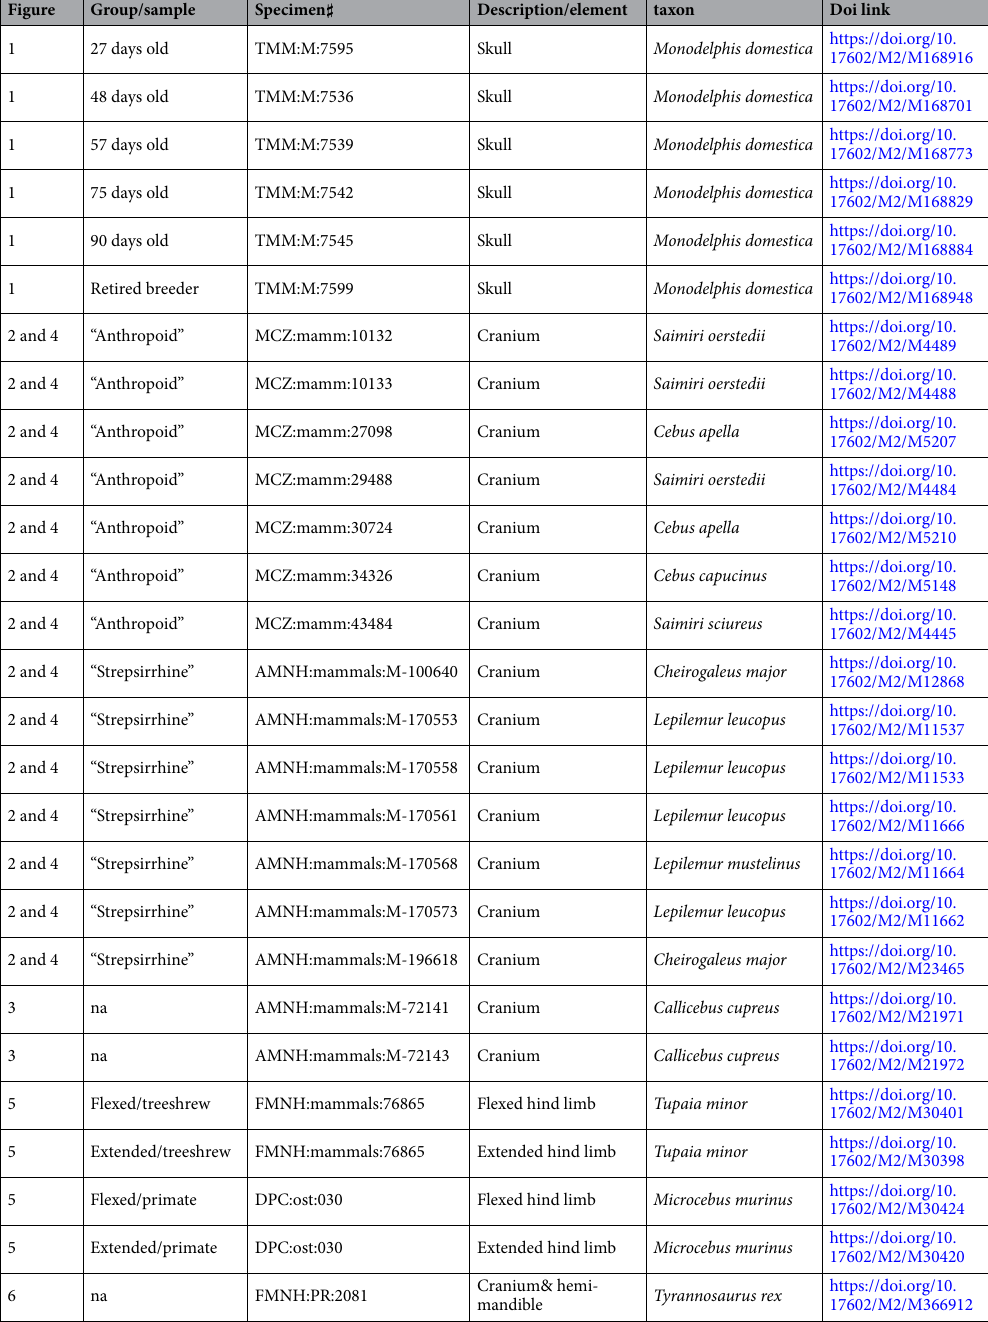
Figure Group/sample Specimen ♯ Description/element